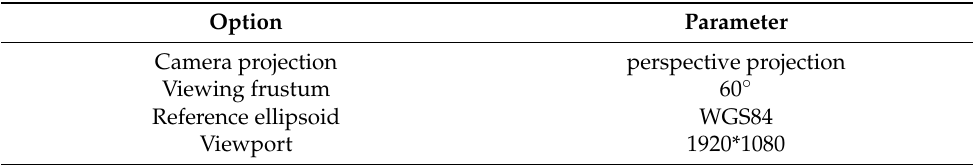
Table 2. Parameters of digital Earth rendering.